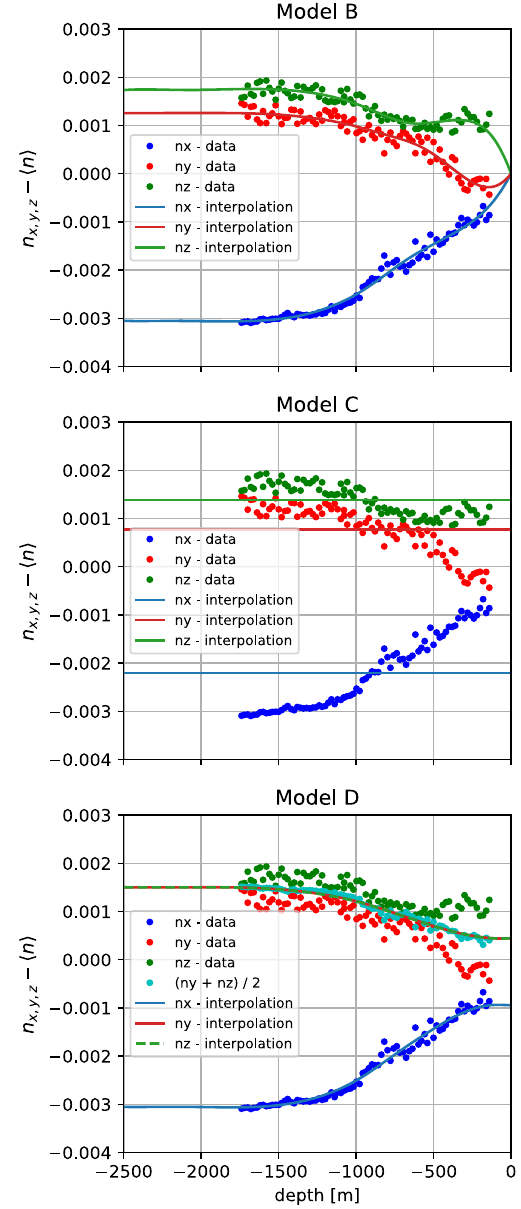
Fig. 15 Refractive index as a function of depth. Measured birefrin- gence data (scatter) [20] compared to the average index-of-refraction value at this depth of (cid:3) n ( z ) (cid:4) . The shown spline interpolation of the data (solid lines) was used in the analysis to create Fig. 13. Model B assumes a converging index of refraction at shallow depths. Model C is a con- stant average over all depths. Model D assumes n y and n z to be the same value at the average of the